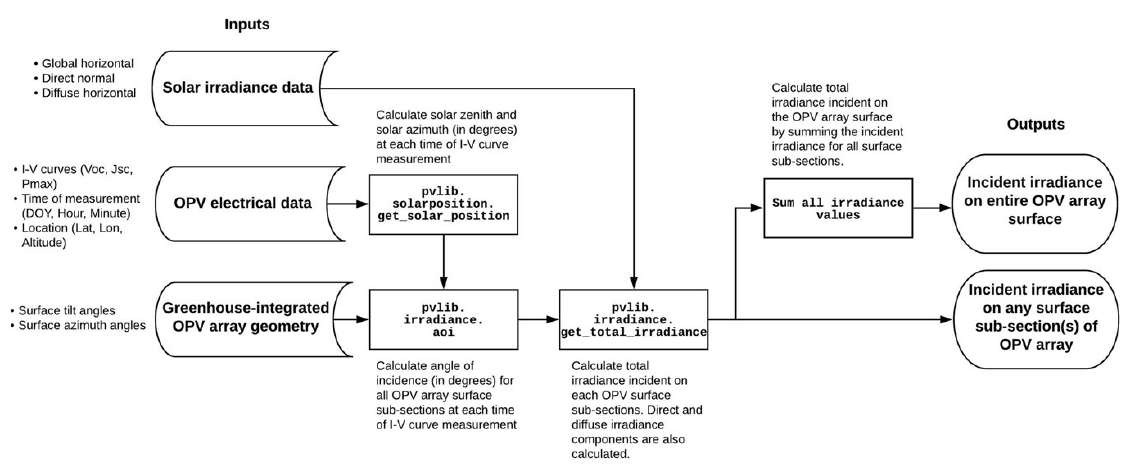
Figure 6. Flowchart methodology for calculating solar irradiance incident on the curved surface of the OPV arrays deployed on the greenhouse.